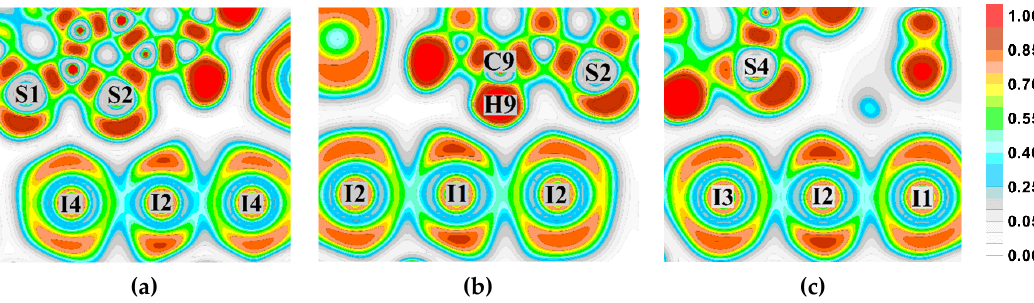
Figure 3. Electron localization function (ELF) distribution in S ... I motives in the structures ( a ) 2a (plane I4—I2 ... S2); ( b ) 2b (plane I1–I2 ... S2); and ( c ) 2c (plane I3–I2 ... S4). Crystals 2019 , 9 , x FOR PEER REVIEW